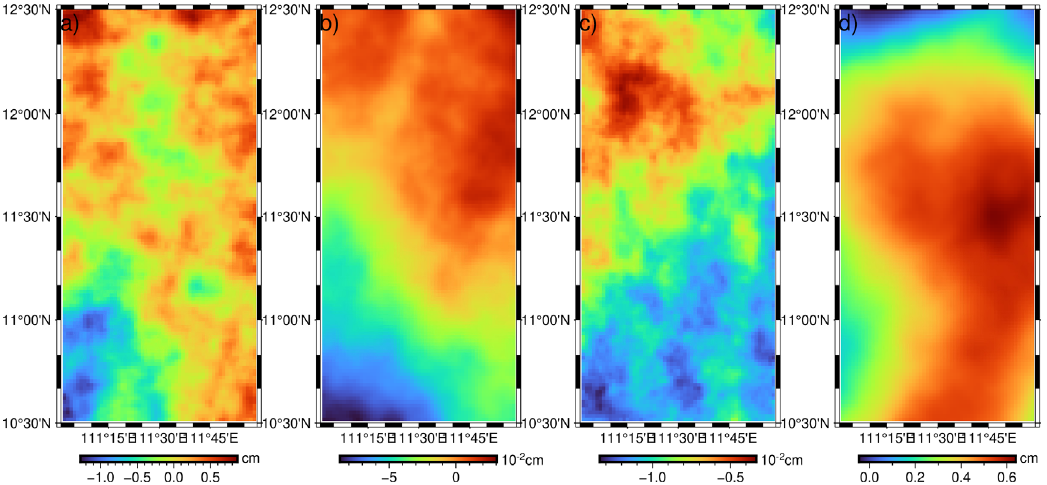
Figure 8. Absolute height error of SSH caused by: ( a ) wet troposphere; ( b ) dry troposphere; ( c ) ionosphere; ( d ) SSB.